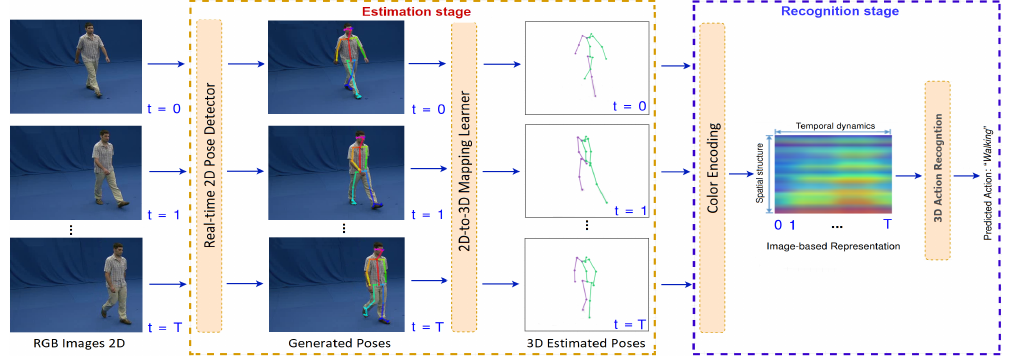
Figure 1. Overview of the proposed method. In the estimation stage, a real-time multi-person 2D pose detector, such as OpenPose [12] or AlphaPose [13], is used to generate 2D human body keypoints. A deep neural network is then trained to produce 3D poses from the 2D detections. In the recognition stage, the 3D estimated poses are encoded into a compact image-based representation and finally fed into a deep convolutional network for supervised classification task, which is automatically searched by the ENAS algorithm